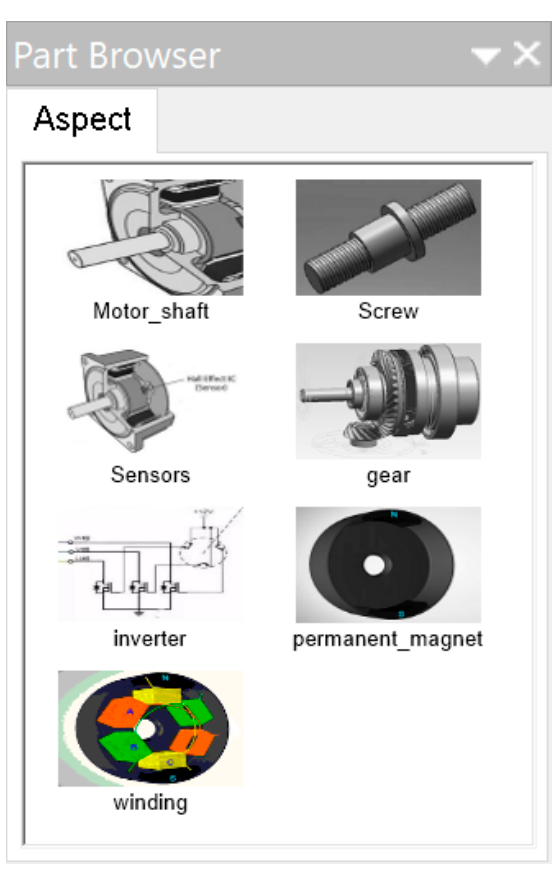
Figure A3. The related submodel of EMA in GME.